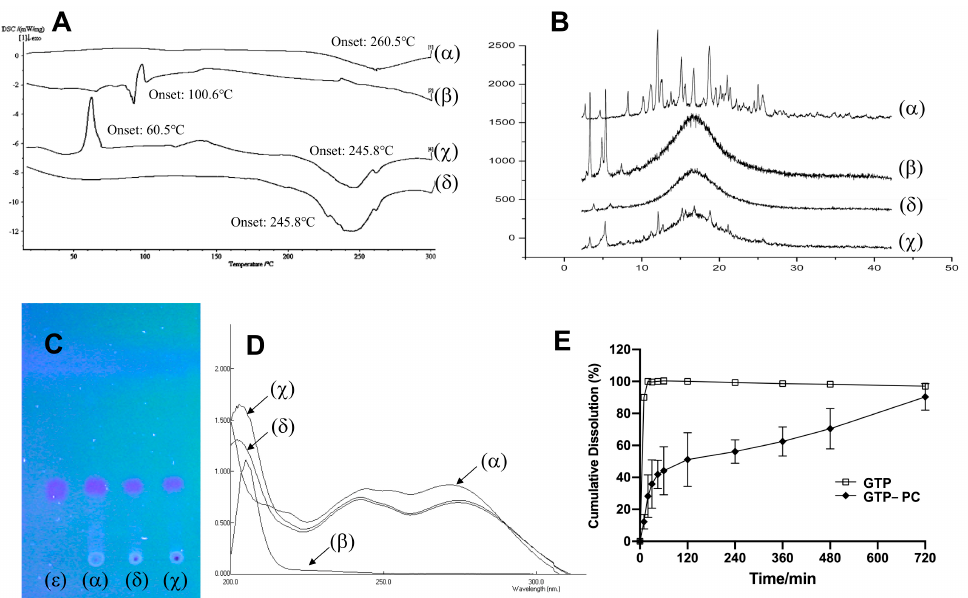
Figure 2. Characterization of GTP-PC. ( A ): Differential scanning calorimetry (DSC). ( B ): X-ray diffractometry (XRD). ( C ): Thin-layer chromatography (TLC). ( D ): Ultraviolet (UV) spectra. ( E ): Degradation of GTP-PC in phosphate buffer solutions and diluted hydrochloric acid at different pH (n = 3). GTP ( α ), phospholipids ( β ), physical mixture ( χ ), GTP-PC ( δ ), and standard GTP ( ε ).